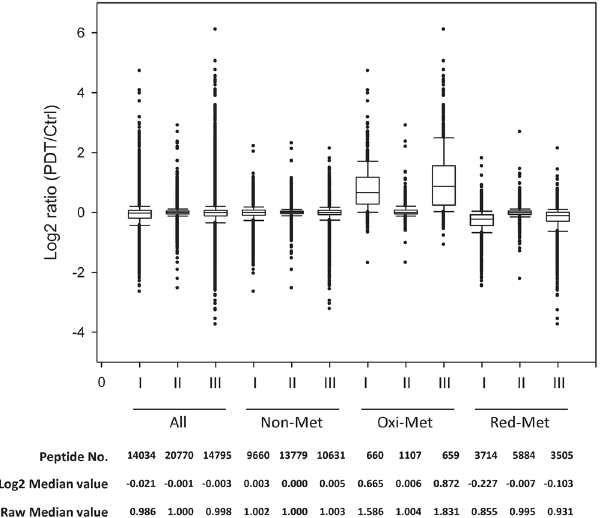
Figure 4. The log2 (PDT/Ctrl) ratio distributions of all identified peptides, non-Met-peptides, oxidized Met- peptides, and reduced Met-peptides under the three conditions. The box represents the 25 to 75% distribution, and the line in the box shows the median ratio. The upper and lower10% distributions are marked at the top and bottom of the box, respectively. The peptide numbers and the ratios of the medians are shown at the